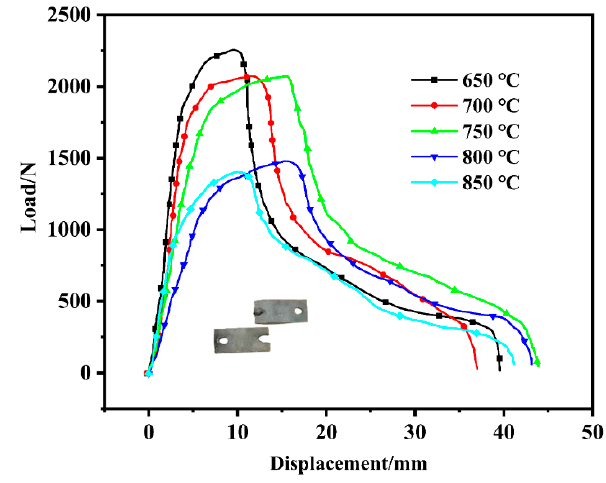
Figure 8. Load–displacement curves of high temperature tensile shear tests.